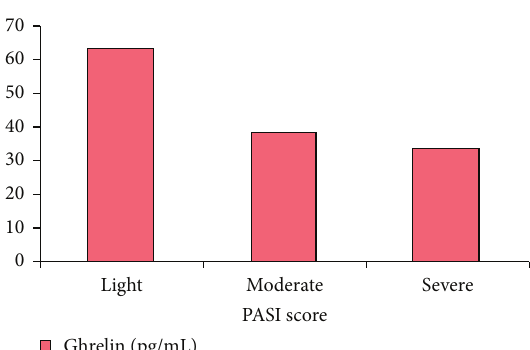
Figure 1: Serum ghrelin, insulin, and HOMA-IR levels.